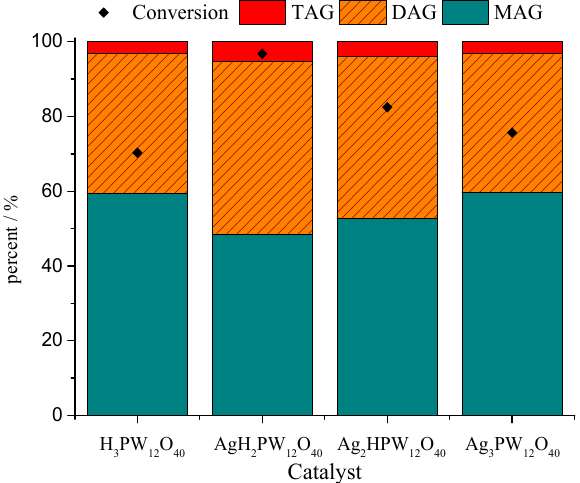
AgH 2 PW 12 O 40 achieved the highest conversion (Figure 13).